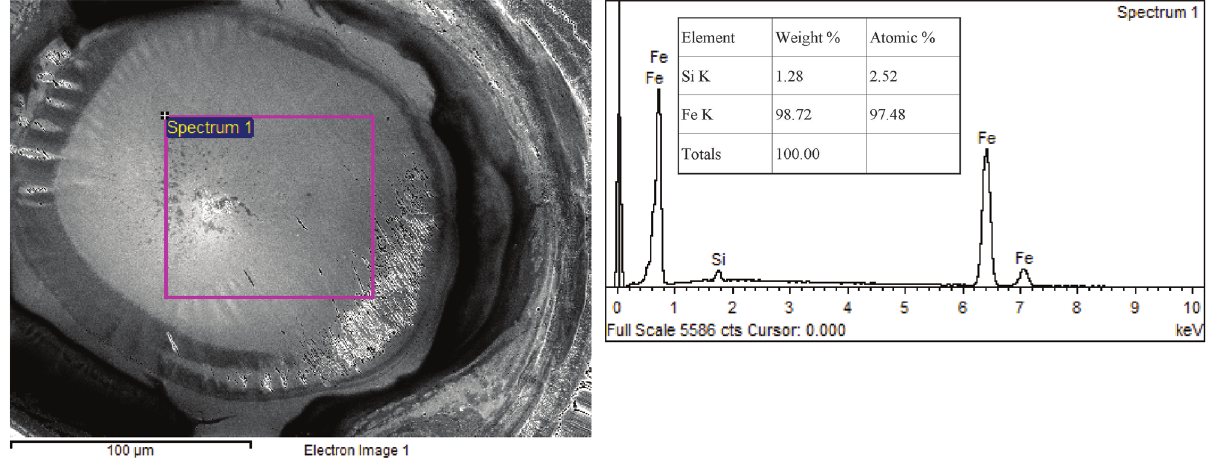
Figure 6: SEM crater morphology and EDS result for 50 mJ laser-treated silicon